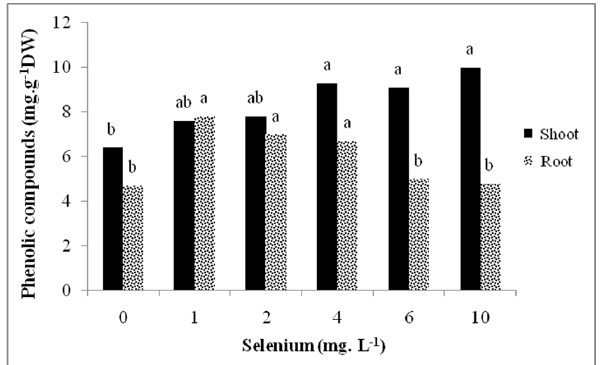
Tab. 2. Effect of selenium supplementation on chlorophyll a,